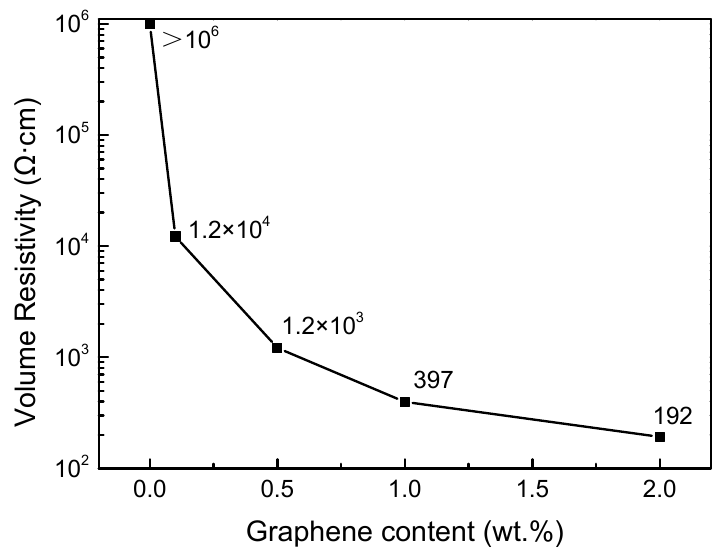
Figure 3. E ff ect of graphene doping on volume resistivity of SiC ceramics. Figure 3. Effect of graphene doping on volume resistivity of SiC ceramics. Table 1. E ff ects of graphene doping on SiC